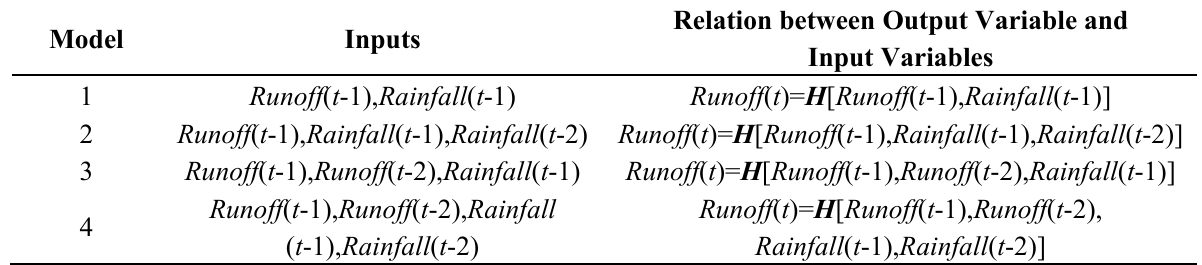
Table 1. Inputs and relation for various artificial neural network (ANN) forecasting models.